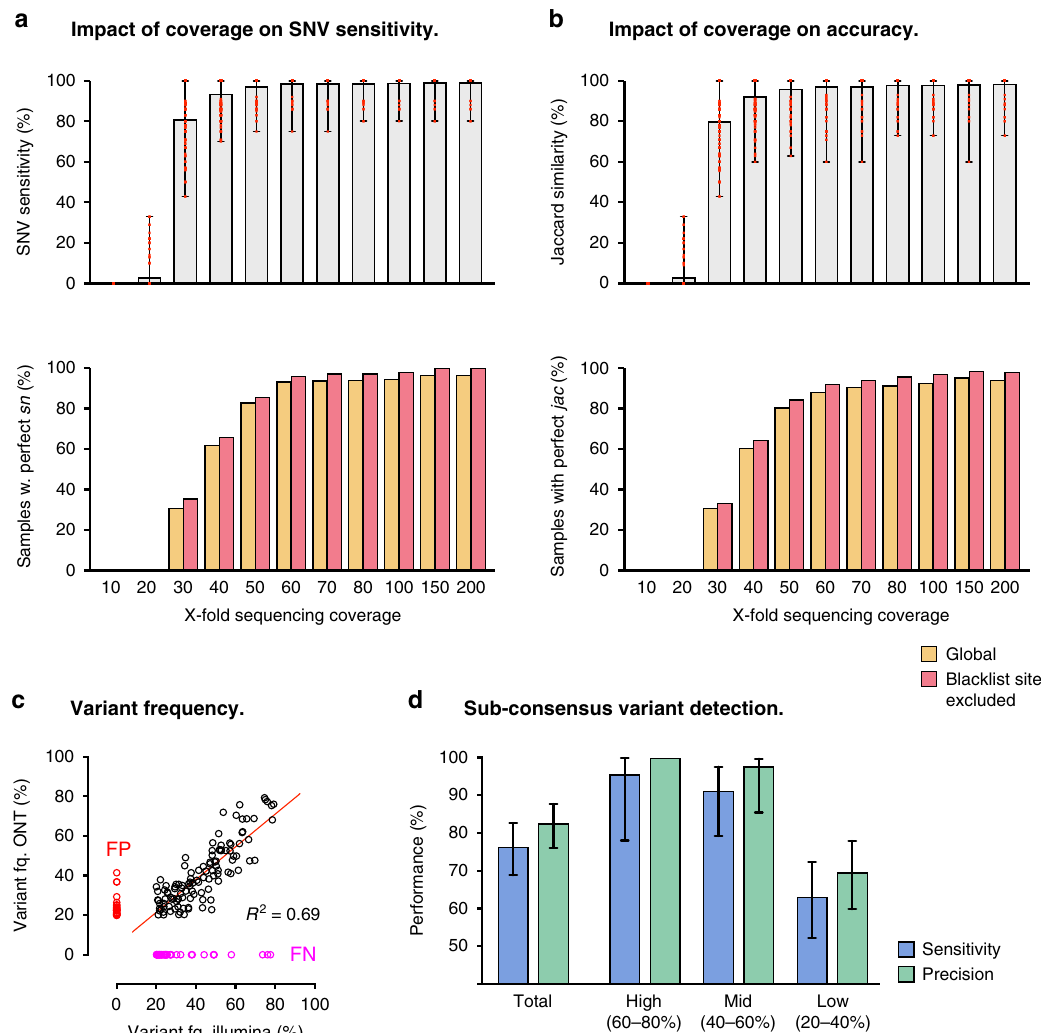
Fig. 1 Variant detection performance for whole-genome ONT sequencing of SARS-CoV-2. ( a ; upper) Sensitivity with which Illumina comparison SNVs at consensus-level variant frequencies (80 – 100%) were detected via ONT sequencing on matched SARS-CoV-2 specimens ( n = 157). Bars show mean ± range. ( a ; lower) Fraction of specimens tested in which SNVs were detected with perfect sensitivity ( sn ). Data are plotted separately for genome-wide variant detection (gold) and variant detection with error-prone ‘ blacklist ’ sites excluded (red). b Same as in a but Jaccard similarity ( jac ) scores for all variant candidates are plotted instead of SNV sn . c Correlation of variant frequencies observed for SNV candidates detected at sub-consensus frequencies (20 – 80%) with Illumina and ONT sequencing. Candidates detected with ONT but not Illumina were considered to be false-positives (FP; red) and candidates detected with Illumina but not ONT were considered to be false-negatives (FP; pink). d Sensitivity (blue) and precision (green) of SNV detection with ONT sequencing at sub-consensus variant frequencies (20 – 80%). Data are plotted separately for high (60 – 80%), intermediate (40 – 60%) and low (20 – 40%) frequencies. Error bars show 95% con fi dence intervals (Clopper-Pearson) calculated over all specimens ( n = 157). Source data are provided as Source Data fi